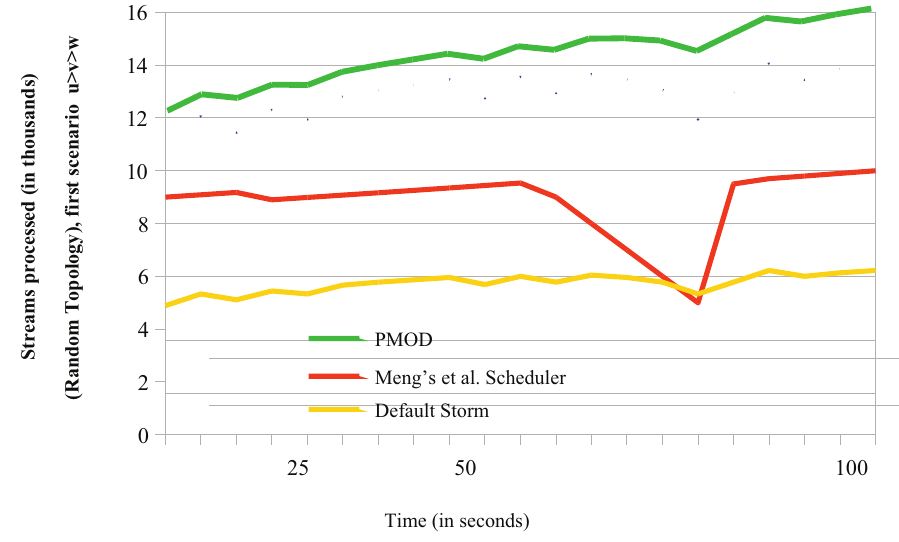
Figure 4. Throughput comparisons with a random topology for the first scenario: ( u > v > w ) .